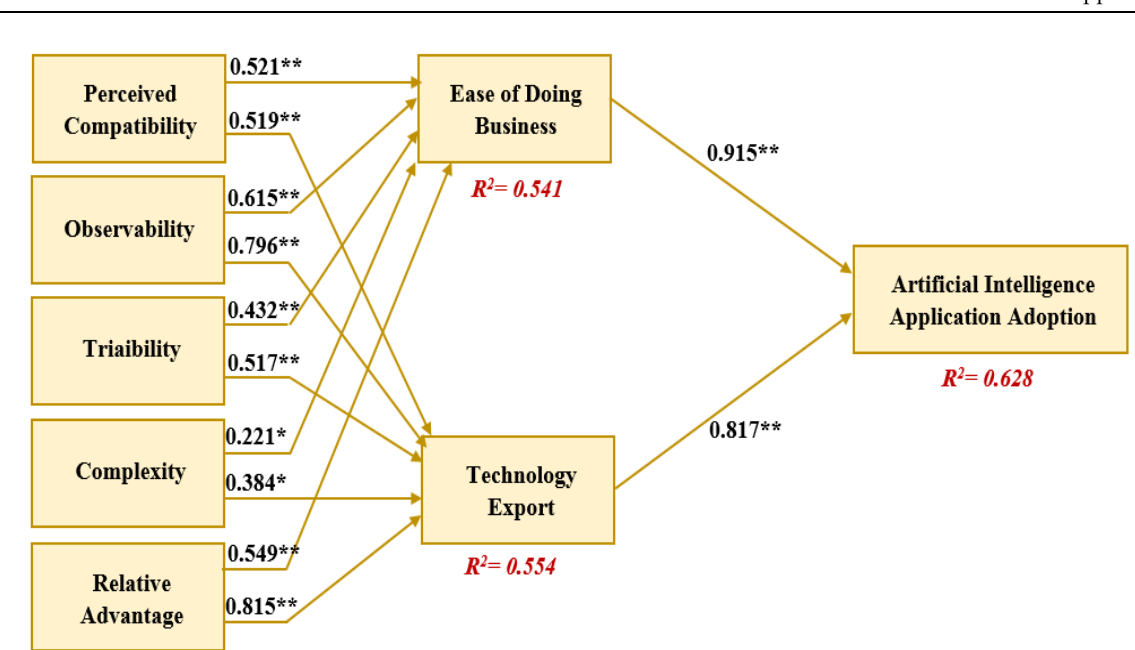
Figure 2. Path coefficient of the model (significant at ** p < = 0.01, * p < 0.05).